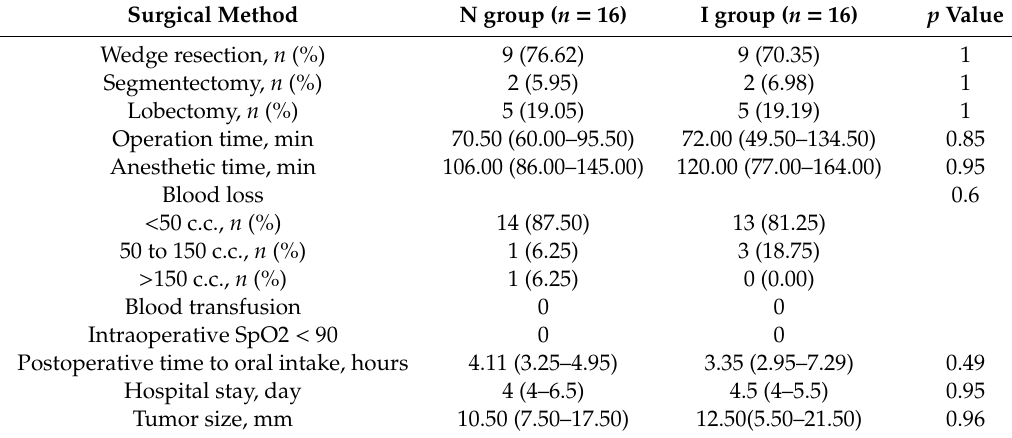
Table 2. Types of surgical procedures in patients receiving N and I